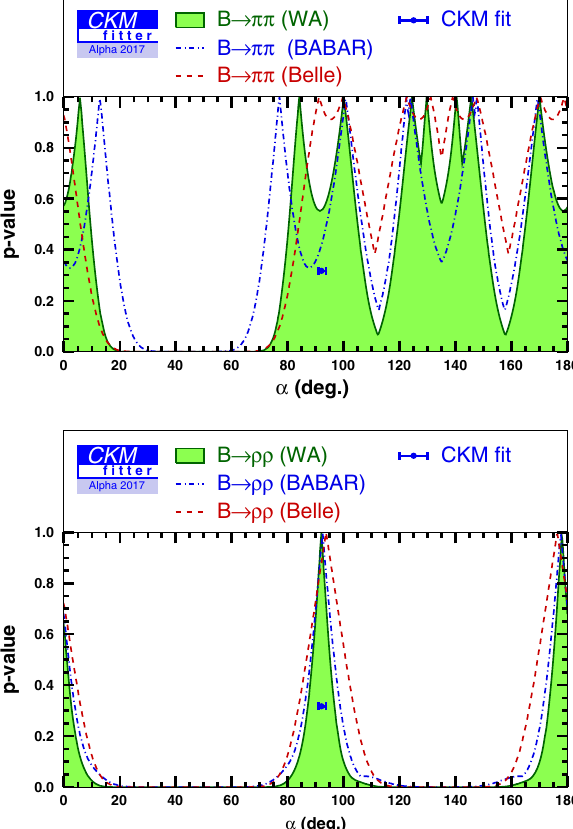
Fig. 46 Constrainton α fromtheisospinanalysisofthe B → ππ ( top ) and B → ρρ system ( bottom ) using BaBar data ( blue curve ) and Belle data ( red curve ). The green shaded area represents the determination based on the world average for these observables. The interval with a dot indicates the indirect determination introduced in Eq.